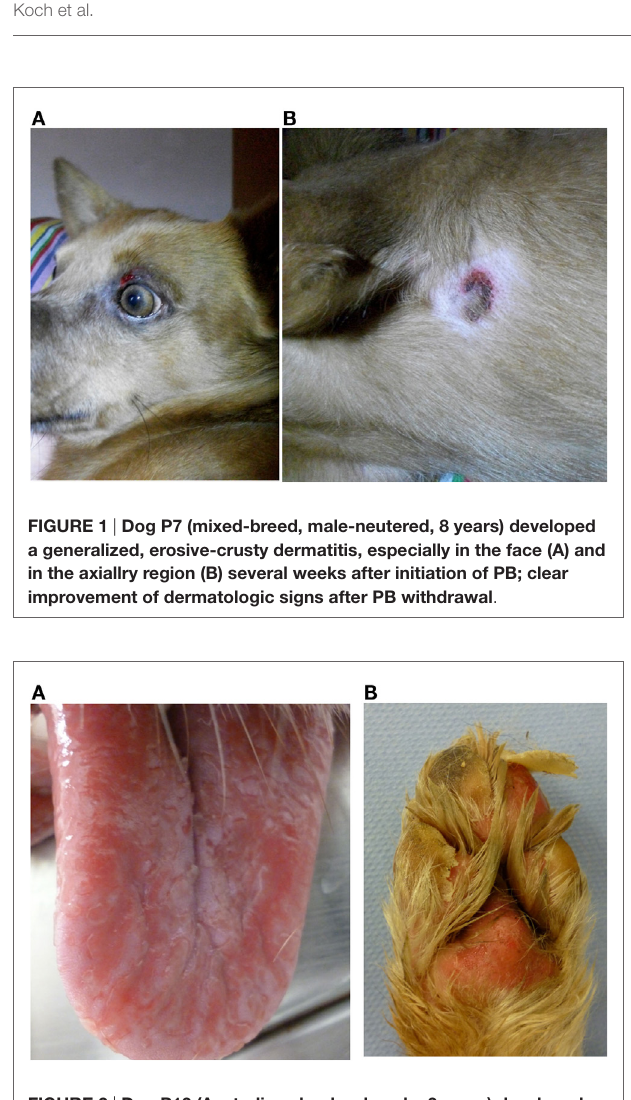
FigUre 2 | Dog P13 (australian shepherd, male, 3 years) developed a generalized, severe, erosive necrolytic dermatitis, especially at the oral mucosa (a), at the mucocutaneous junctions and the foot pads (B) 1–2 weeks after PB initiation; additionally affected were the testicles and the perianal, inguinal and axillary areas . After withdrawal of PB therapy, the skin lesions resolved completely within 2 weeks.